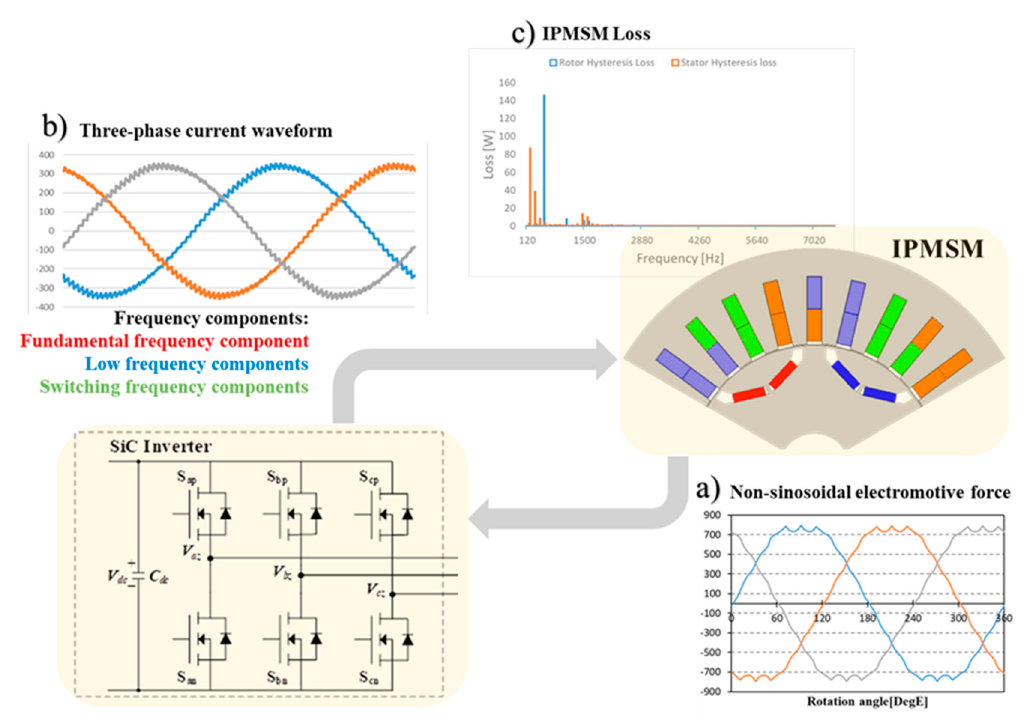
Figure 5. Interaction between SiC inverter and